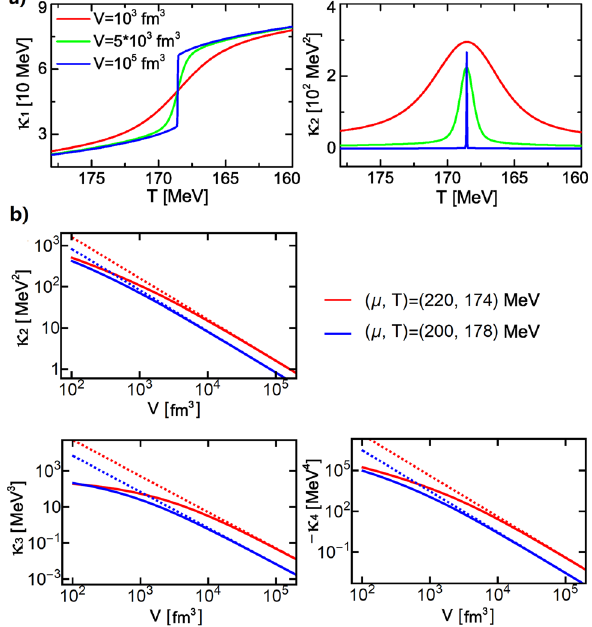
Fig. 2 a The cumulants κ 1 and κ 2 of the σ field as functions of the temperature with different fixed volumes in the first order phase tran- sition regime. The chemical potential is fixed at μ = 250 MeV. b The κ ,κ κ 2 3 and 4 as functions of volume in the crossover regime. The solid lines are given by Eqs. (11)–(13). The dotted lines represent fluctua- tions determined by the Gaussian approximation, ˜ κ 2 = T ξ 2 / V , and the perturbative results ˜ κ 3 and ˜ κ 4